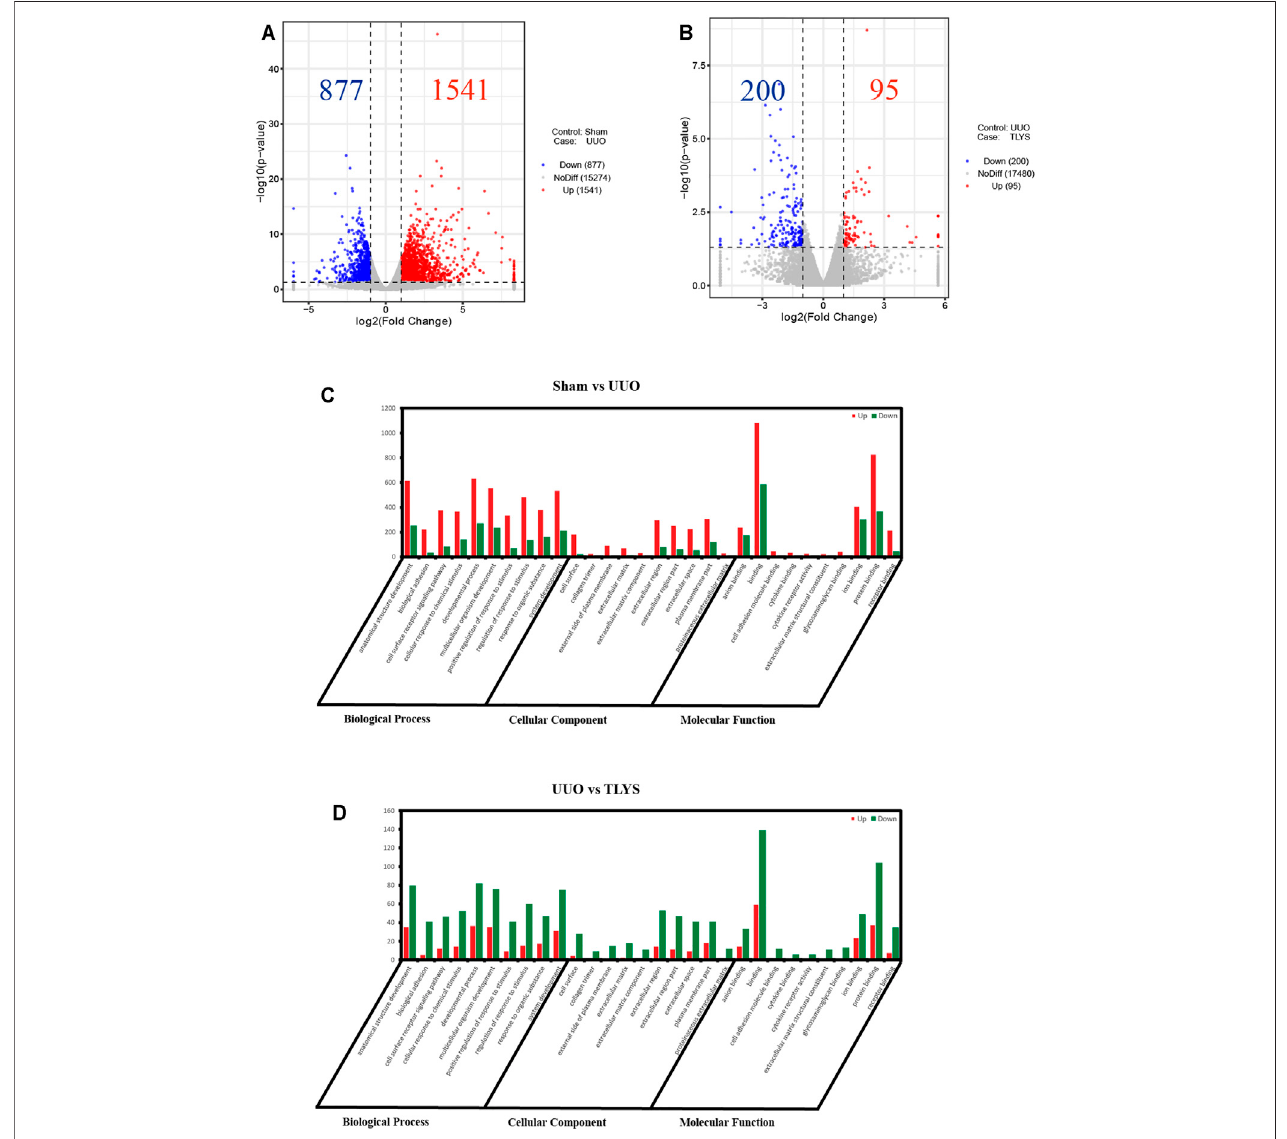
FIGURE 4 | TLYS decoction played comprehensive regulatory roles in UUO rats. (A,B) Volcano plot of genes with signi fi cant differences, FDR < 0.05, |log FC| > 1. (C,D) Gene Ontology (GO) function analysis of genes with signi fi cant differences in three experimental groups. Three independent samples were tested in each experimental